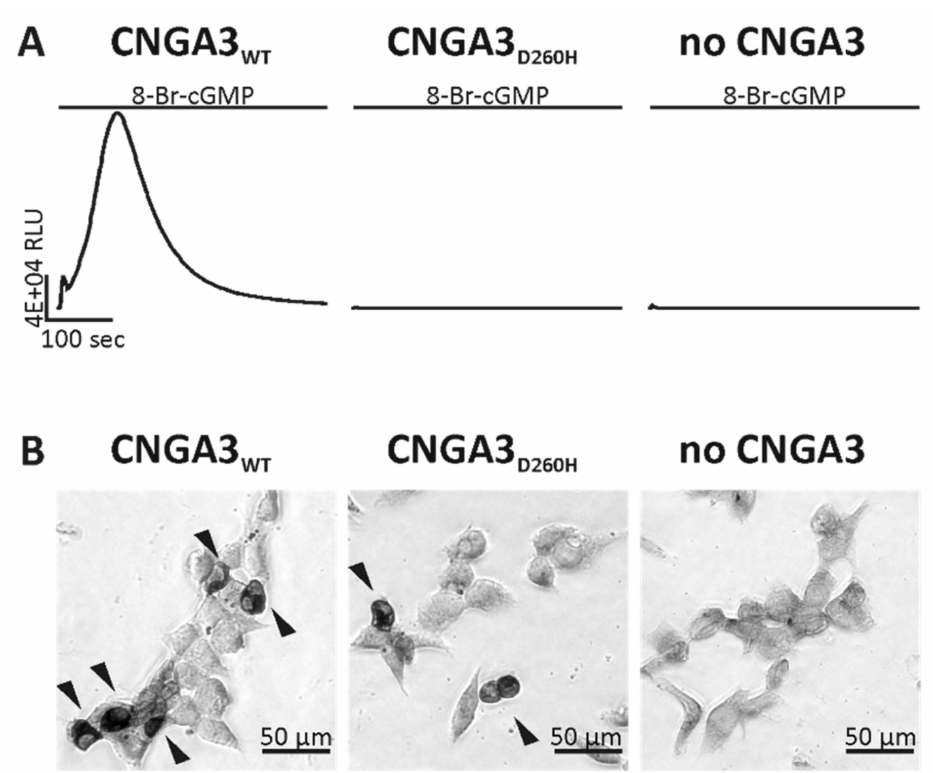
Figure 2. Aequorin-mediated luminescence signals and immunocytochemical staining of wild- type (WT) and mutant (D260H) CNGA3 channels. ( A ) The luminescence signal of HEK293 cells either expressing aequorin and CNGA3 WT (left) or aequorin and CNGA3 D260H (middle) or aequorin only (right) was recorded for a duration of 400 s. Application of the CNGA3 channel ligand 8- bromoguanosine-3 (cid:48) ,5’-cyclic monophosphate (8-Br-cGMP) 6 s after starting the recording resulted in an increase of the luminescence signal only in cells expressing CNGA3 WT . HEK293 cells expressing mutant CNGA3 D260H displayed no luminescence signal classifying the variant as non-functional. Cells expressing aequorin-only served as a negative control. RLU: relative light units. ( B) Detection of CNGA3 protein expression was conducted by immunocytochemical diaminobenzidine staining. HEK293 cells expressing the CNGA3 channel protein are marked with an arrow head. Expression of the channel mutant CNGA3 D260H in HEK293 cells could be confirmed (middle). CNGA3 WT - expressing cells (left) and cells expressing no CNGA3 channel (right) served as a positive and negative controls,